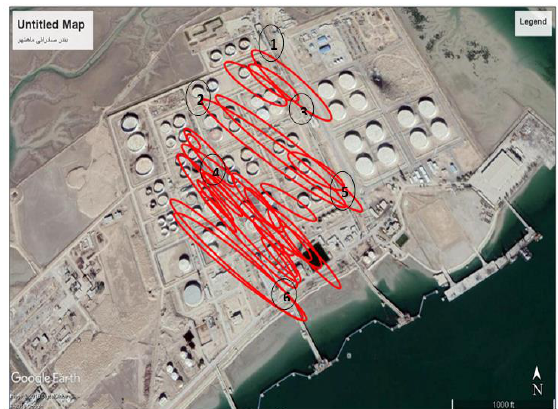
Fig. 3. VOC emissions from storage tanks in hot season and selected points for field measurements